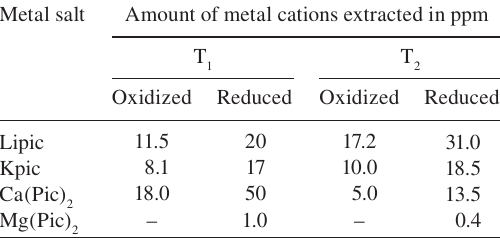
Table 1 Amount of metal cations extracted after 4 h with ionophores T and T . 1 2